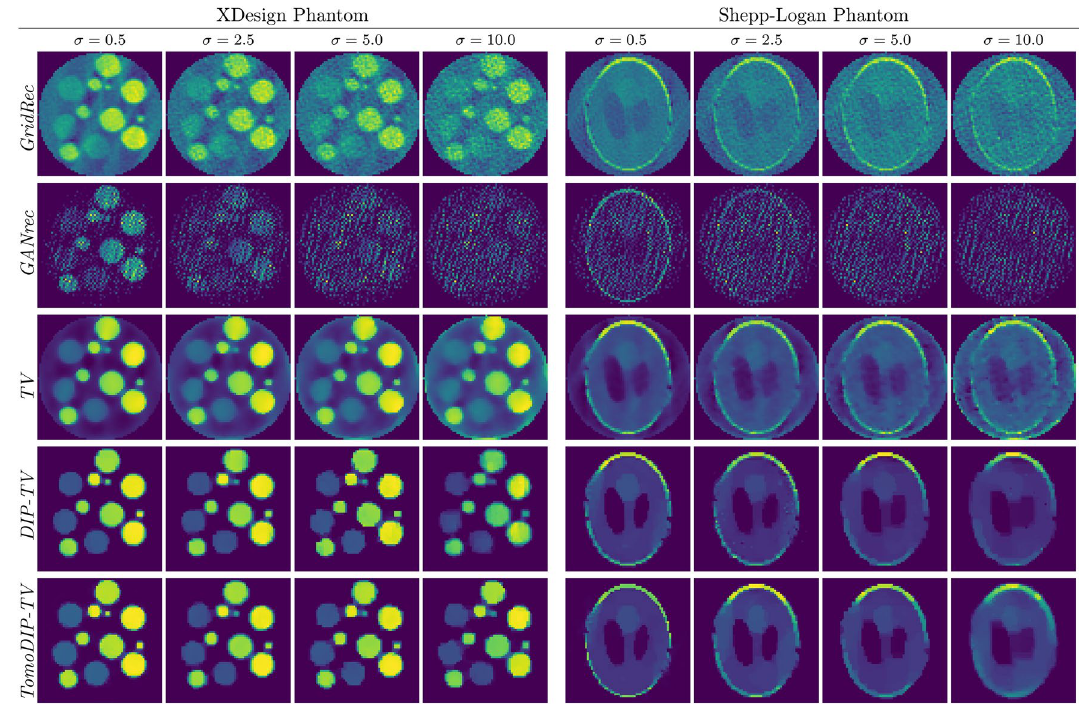
Figure 7. Reconstruction comparison for the XDesign phantom and the Shepp–Logan phantom for different noise levels and for projections between 0 ◦ and 150 ◦ .